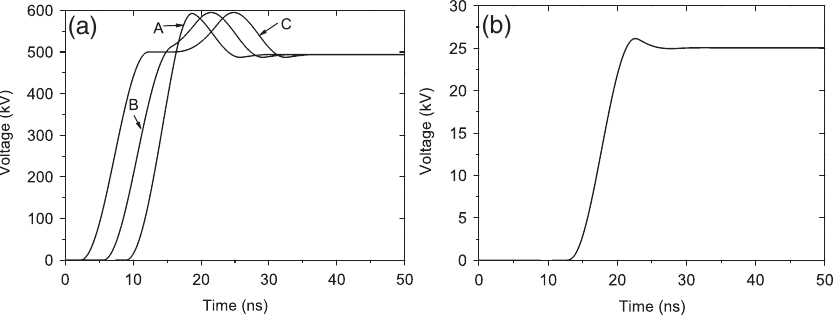
FIG. 6. (a) Input voltage and (b) output voltage versus time for injection voltage having rise time of 10 ns [see Fig. 3(c) for the meaning of A, B, and C].